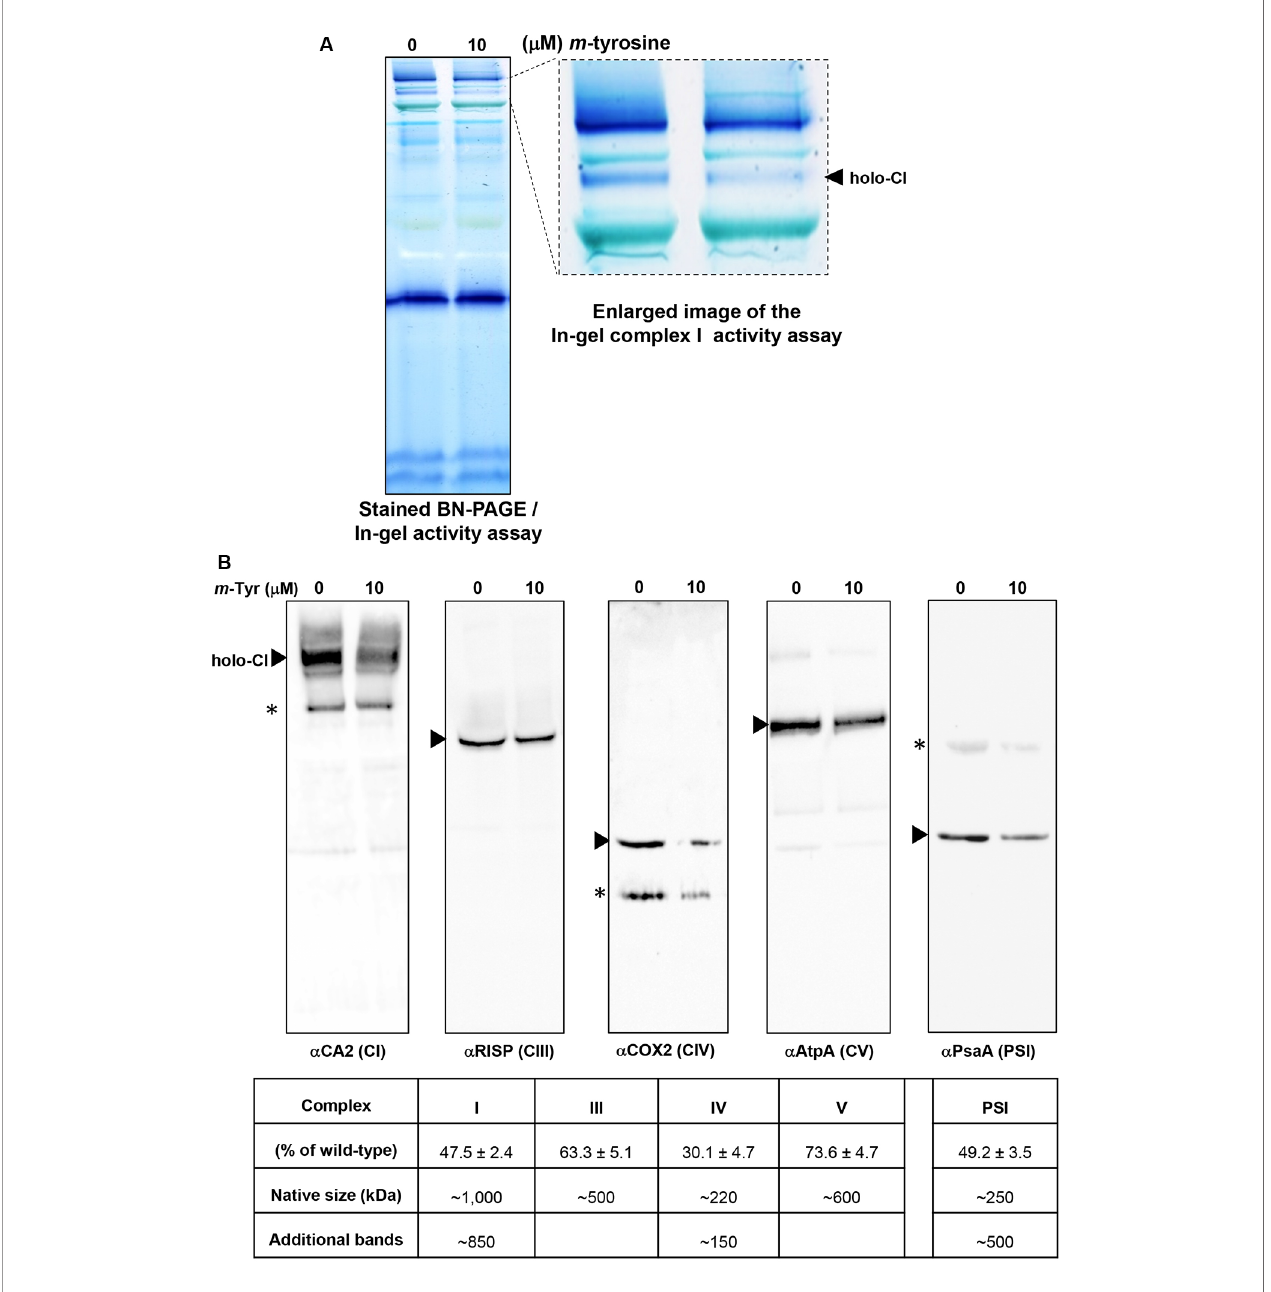
FIGURE 6 | Relative accumulation of native organellar complexes in 5-day-old Arabidopsis plants grown in the absence or presence of m -tyrosine. Blue native- polyacrylamide gel electrophoresis (BN-PAGE) of crude organellar preparations was performed according to the method described in Pineau et al. (2008). Equal amounts of crude membranous fractions (equivalent to 50 mg fresh-weight seedlings), were obtained from 5-day-old Arabidopsis seedlings, solubilized with 1.5% n-dodecyl- b -d-maltoside (DDM), and the organellar complexes were resolved by BN-PAGE. (Panel A ) shows stained PAGE, followed by in-gel activity assay of complex I, according to the method described in Eubel et al. (2005). For immunodetections (panel B ), proteins were transferred from the native gels onto a polyvinylidene di fl uoride (PVDF) membrane (see Materials and Methods ) and then probed with speci fi c antibodies (see Table S1 ), as indicated below each blot. Arrows indicate to the native mitochondrial complexes I (~1,000 kDa), III (dimer, ~500 kDa), IV (~220 kDa), V (~600 kDa), and the plastidial PSI complex (~250 kDa). Asterisks in the COX2 and PsaA panels indicate the presence of lower or higher (respectively) molecular weight particles of unknown origins. Hybridization signals were analyzed by chemiluminescence assays after incubation with horseradish peroxidase (HRP)-conjugated secondary antibody. The intensities of protein signals in (panel B ) were evaluated using the ImageJ software (Jensen, 2013). The data shows the relative accumulation of each protein in untreated versus m -tyrosine-treated seedlings. The data shows the relative accumulation of each protein in untreated versus m-tyrosine-treated seedlings (panel C ). The values are means of three biological replicates ±